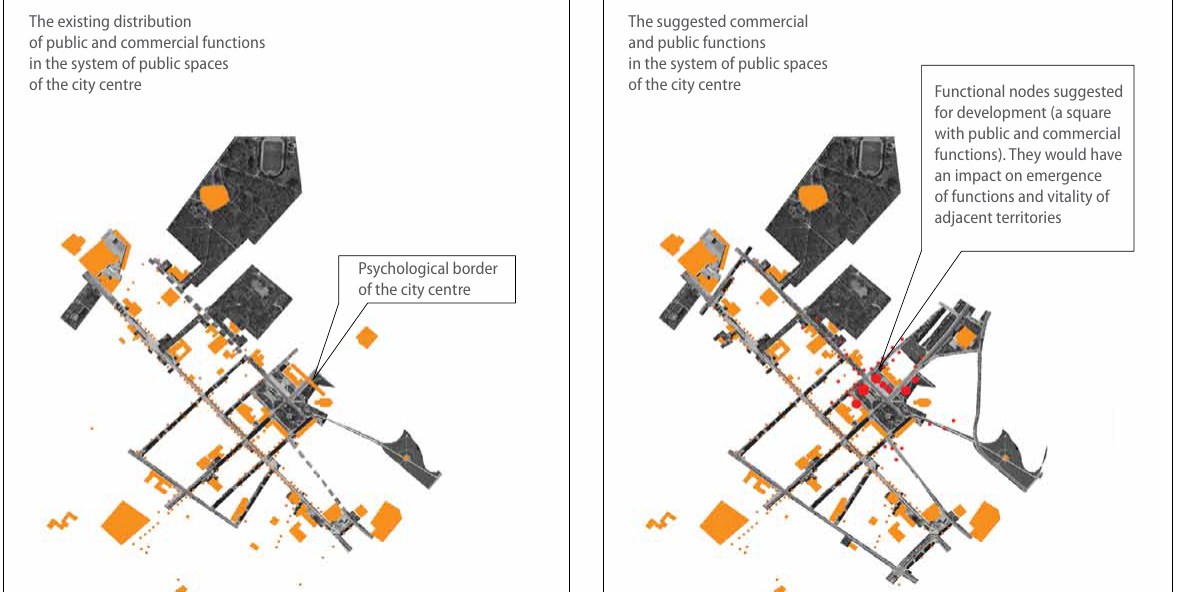
fig. 2. The system of public spaces in the centre of Šiauliai. analysis and proposals by the aEXn